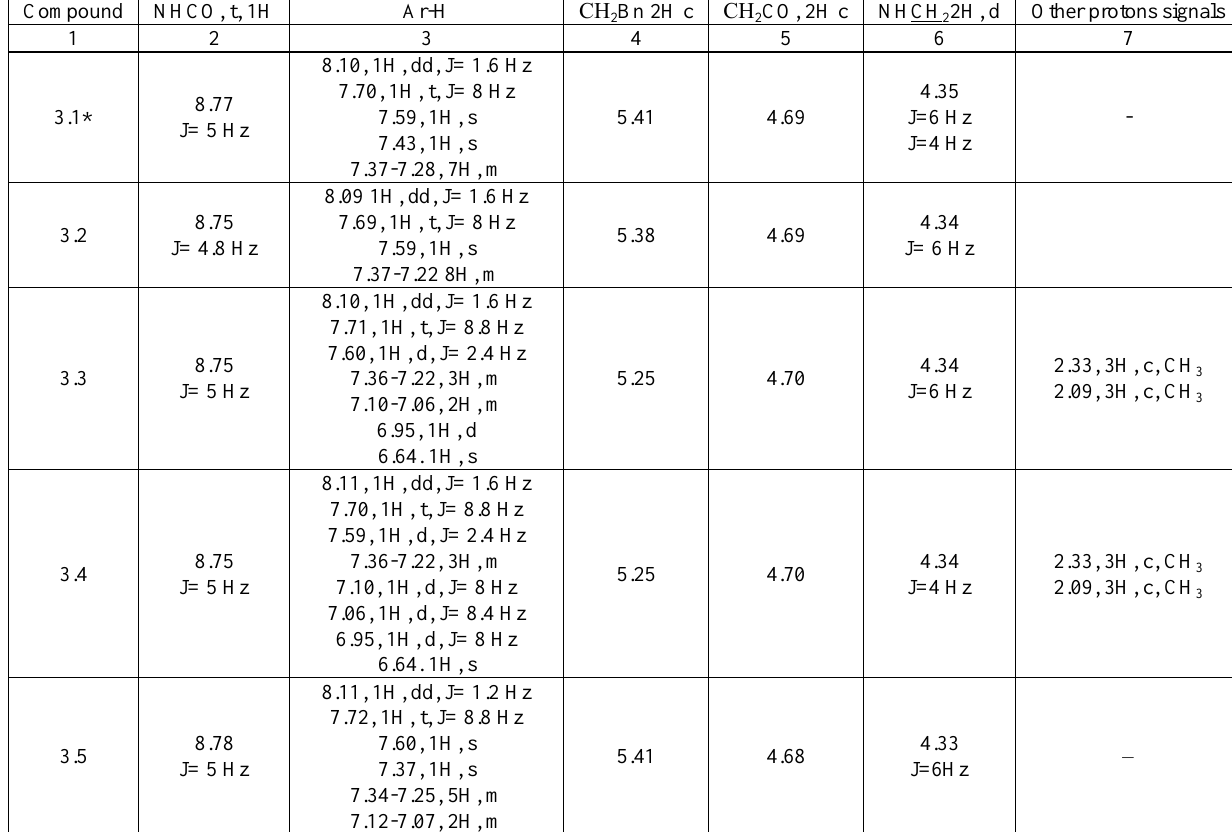
1 H NMR spectra of the synthesized 1-benzyl derivatives of